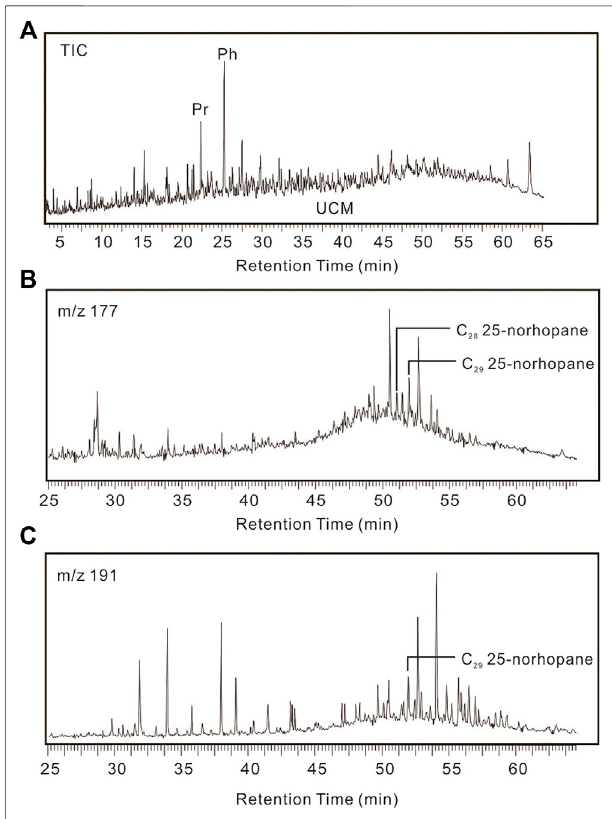
Frontiers in Earth Science |